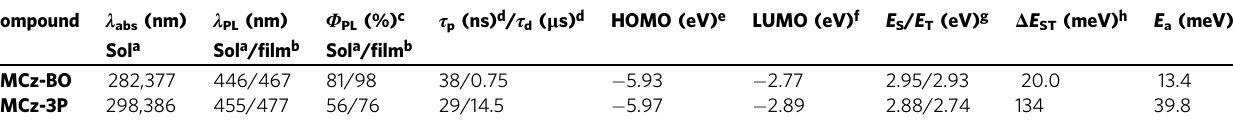
Table 1 Photophysical characteristics of TMCz-BO and